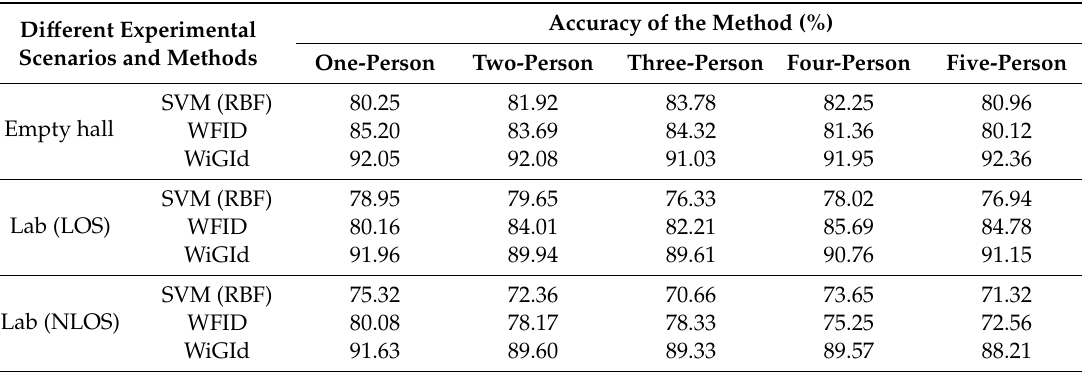
Table 1. Performance comparison table of WIGID and other